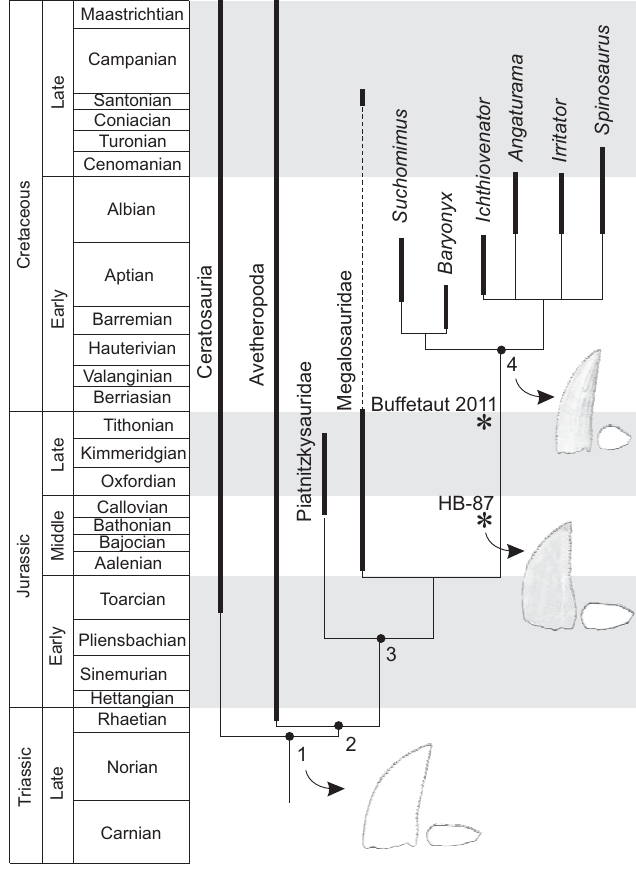
Fig. 5. Time-calibrated phylogeny of spinosaurids and related theropods. Time-calibrated cladogram elaborated after Carrano et al. (2012) and Allain (2014). The asterisks mark the place of the three basal spinosaurid forms represented only by teeth (Buffetaut et al. 2011; this article). The proposed transition from a plesiomorphic theropod tooth (node 1 and ear- lier) to a highly derived spinosaurid tooth (node 4) would include a transi- tional state (represented by MUPE HB-87). 1, Averostra; 2, Tetanurae; 3, Megalosauroidea; 4,